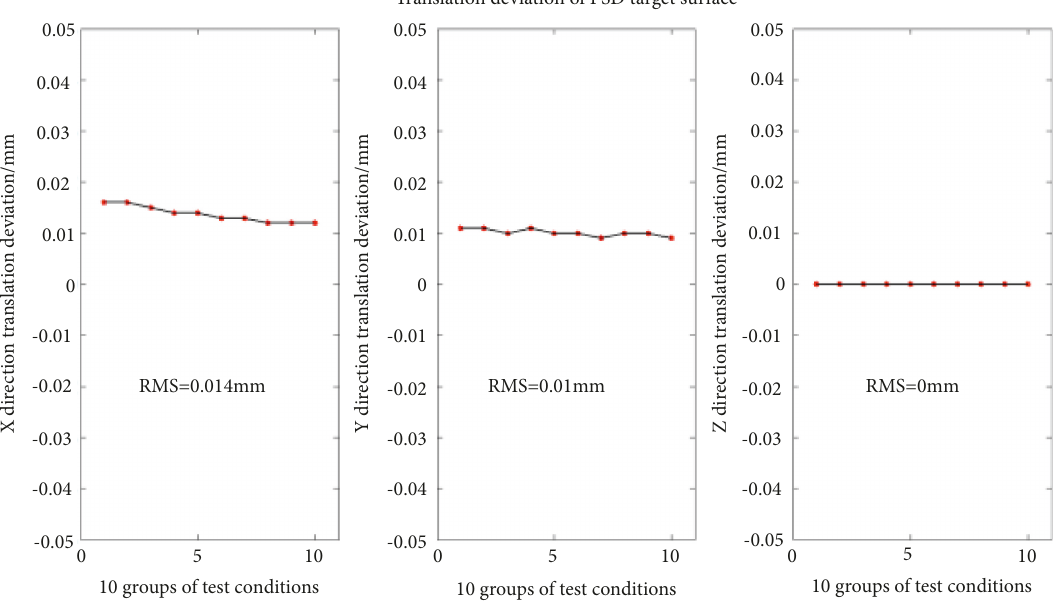
Figure 18: Last 10 groups of the PSD 3-DOF attitude translation errors.